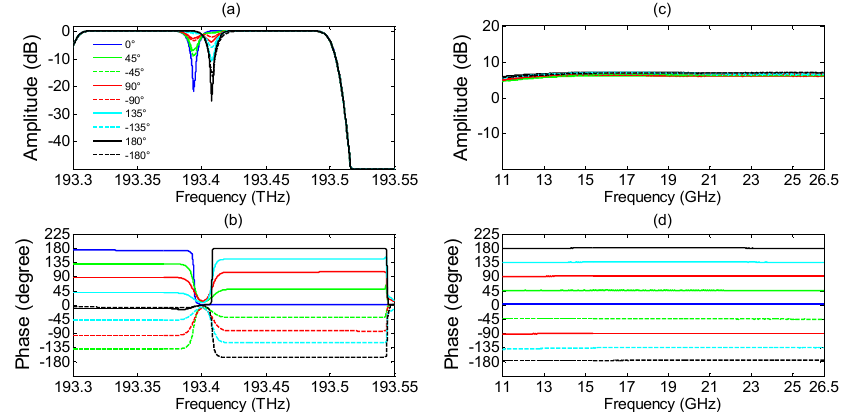
Figure 9. ( a ) Amplitude and ( b ) phase response profile of the LCOS based optical processor designed for improving the phase shifter SNR performance, and corresponding measured phase shifter output RF ( c ) amplitude and ( d ) phase response for different phase shifts.